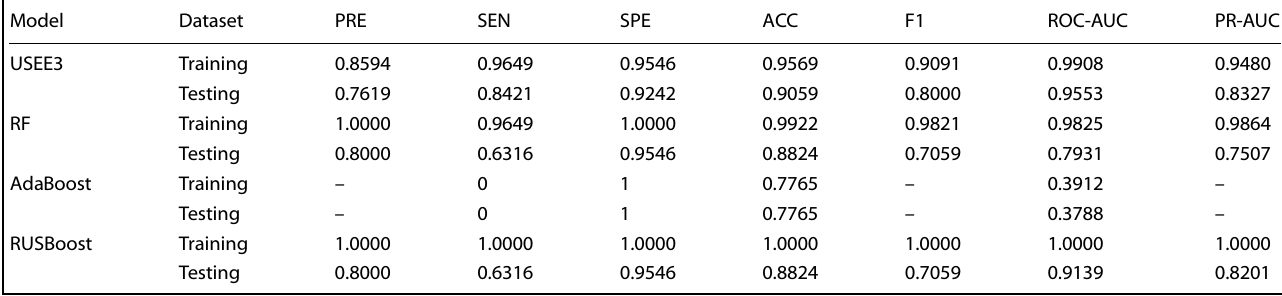
Table 3. Comparison of the classi fi cation effects of various methods.